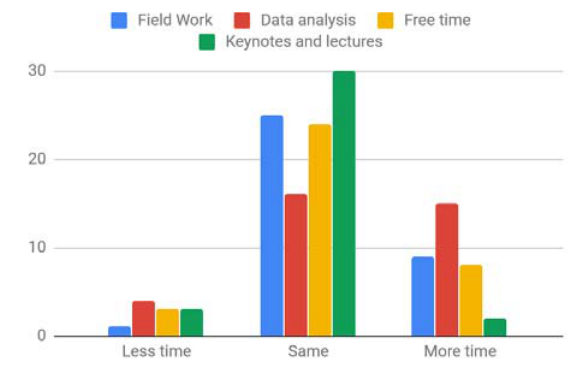
Figure 14. Participants’ feedback on time schedule.